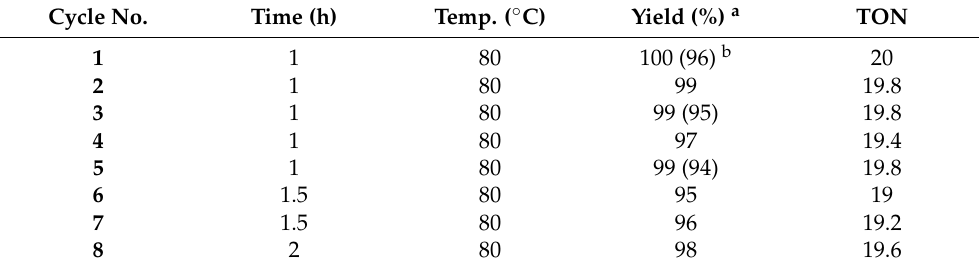
Table 4. Recycling results of A -catalyzed phospha-Michael addition of dimethyl phosphite ( 1b ) with 2-benzylidenemalononitrile ( 3 ). Cycle